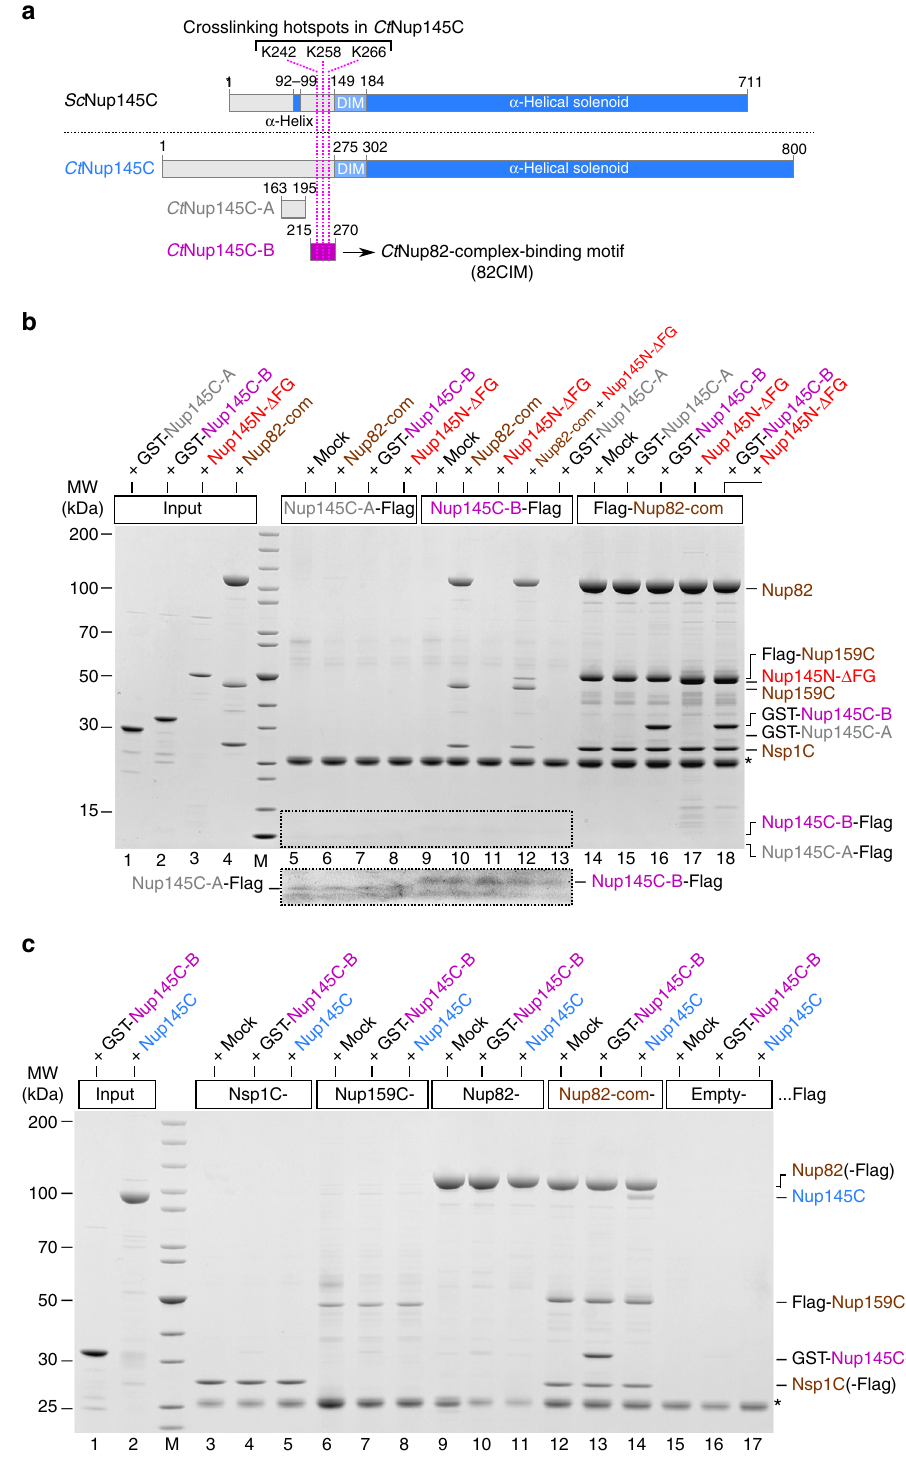
Fig. 4 Identi fi cation of a short linear motif (SLiM) in Ct Nup145C-NTD that recruits the Ct Nup82 complex. a Schematic representation of Sc Nup145C and Ct Nup145C and the design of truncated Ct Nup145C-A and Ct Nup145C-B motifs; see also Supplementary Fig. 2. The crosslinking hotspots found in Ct Nup145C-NTD (Fig. 1b) are indicated by dashed pink lines. DIM domain invasion motif. b In vitro binding assay with Flag-immobilized Ct Nup145C-A, Ct Nup145C-B, and Ct Nup82 complex (Flag- Ct Nup159C – Nup82 – Nsp1C) and soluble GST- Ct Nup145C-A, GST- Ct Nup145C-B, Ct Nup82 complex, and/or Ct Nup145N- Δ FG. Shown is the analysis of SDS eluates by SDS-PAGE and coomassie staining. The image section marked by the dashed box was subjected to image processing to increase the visibility of the small bait peptides Ct Nup145C-A-Flag and Ct Nup145C-B-Flag. c In vitro binding assay with Flag- immobilized Ct Nsp1C, Ct Nup159C, Ct Nup82, and Ct Nup82 complex (Flag- Ct Nup159C – Nup82 – Nsp1C) and soluble GST- Ct Nup145C-B or Ct Nup145C. The experiments were performed at least twice with consistent results. The asterisk indicates bands corresponding to the anti-Flag light chain; M marker, Mock puri fi cation buffer with E. coli whole cell lysate, MW molecular weight. Uncropped gel images are shown in Supplementary Fig. 4e,